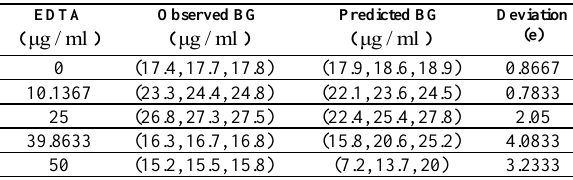
Table 9. Predicted BG content and deviations for EDTA